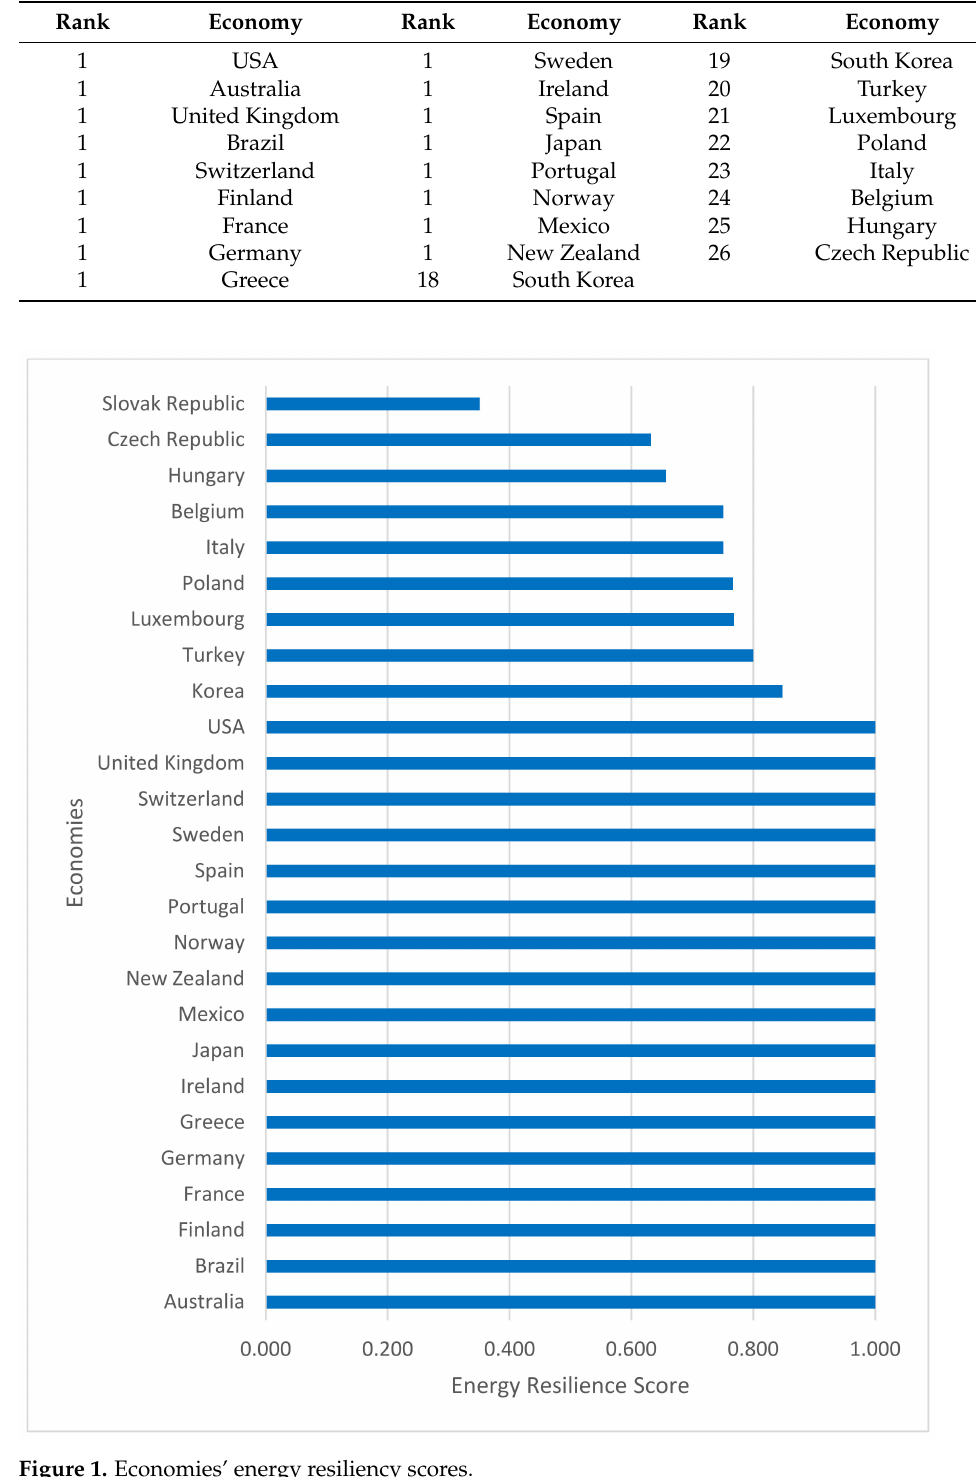
Table 4. Rankings in energy resiliency scores.